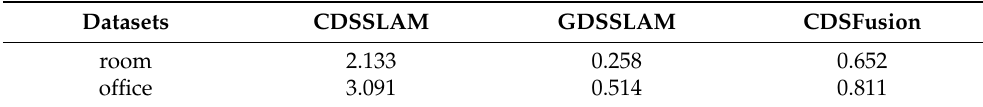
Table 7. Time of semantic segmentation per frame comparisons between three different methods in